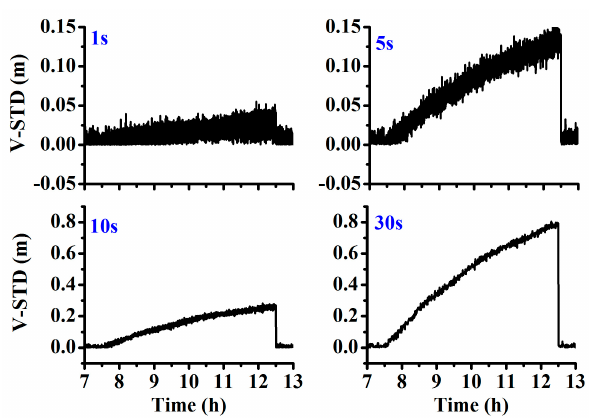
Figure 10. STD of the observation residuals for different sample rates at the station CUT0.